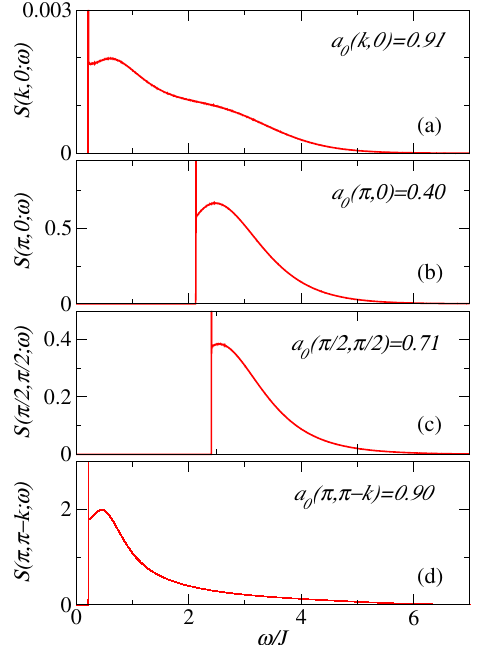
FIG. 6. Dynamic structure factor for the L ¼ 48 system at four different momenta. The smallest momentum increment 2 π =L is denoted by k in diagrams (a) and (d). The relative amplitude of the magnon pole is indicated in each